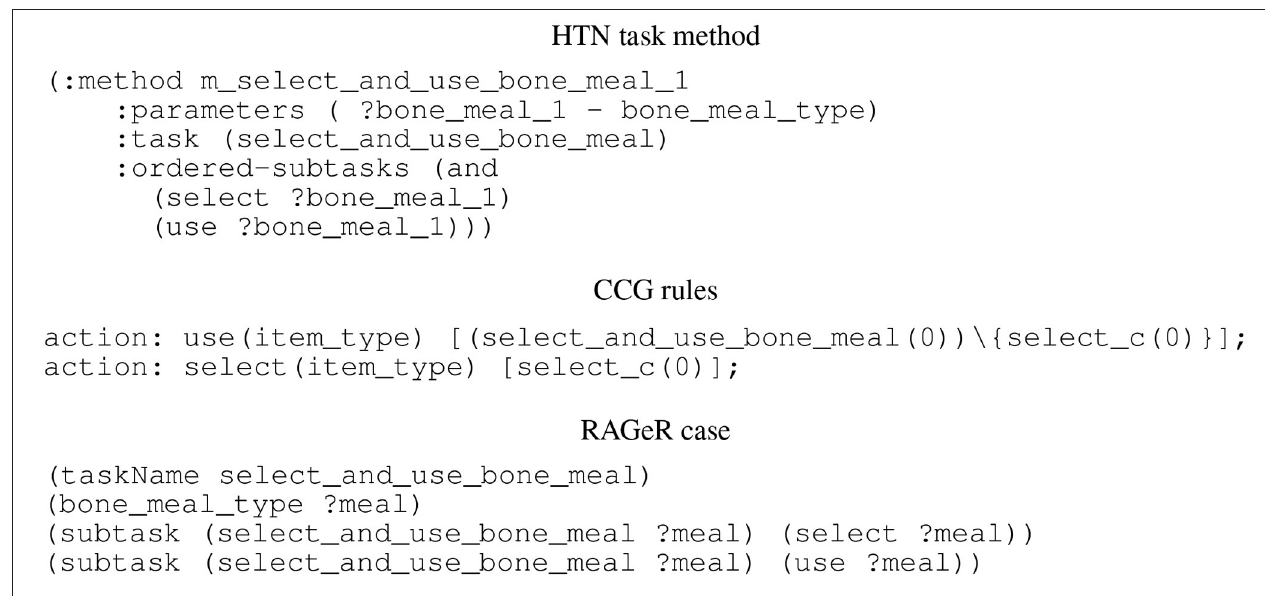
FIGURE 1 | A method in the HTN model used by PANDA-REC, and corresponding CCG rules used by Elexir-MCTS and case in the case library used by